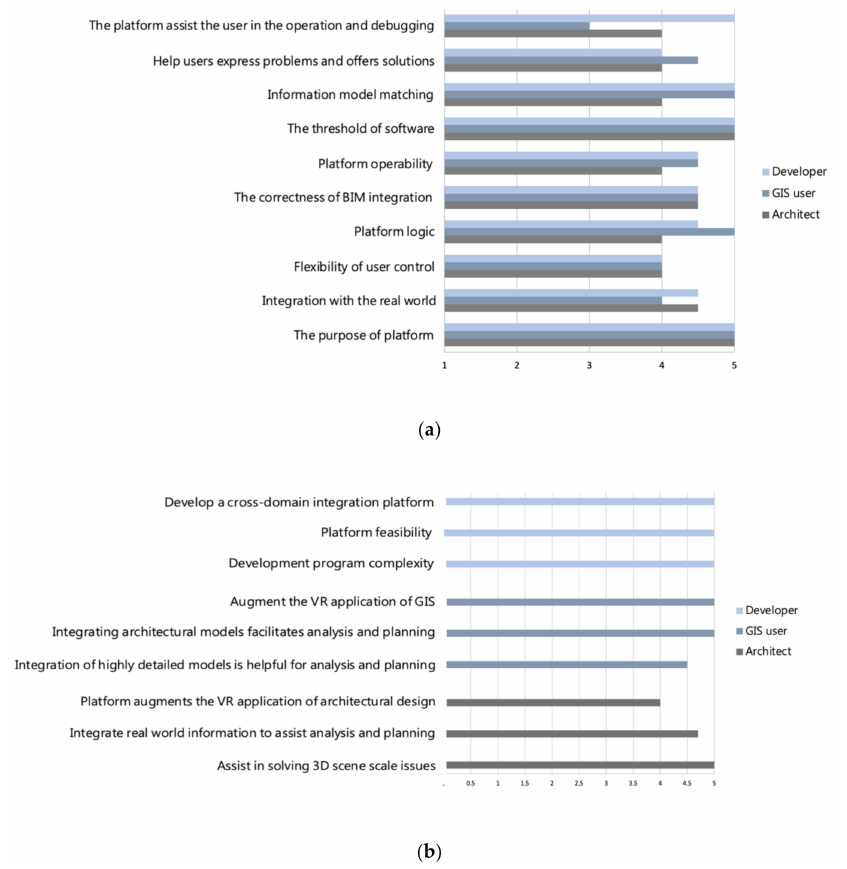
Figure 19. UX design evaluation, ( a ) UX usability heuristics, and ( b ) the feeling of respondents from different backgrounds after using the